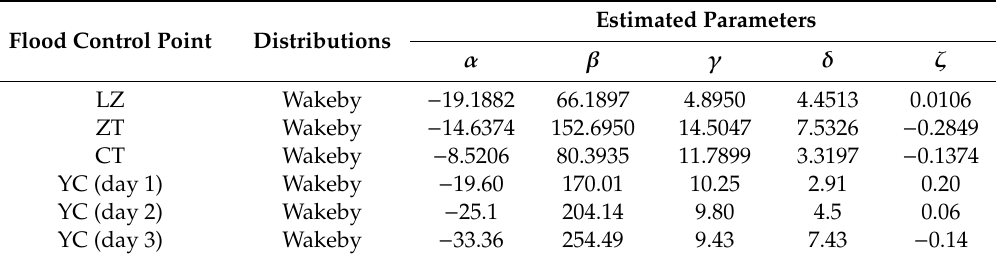
Table 2. Estimated parameters of distributions of flood forecast uncertainties.